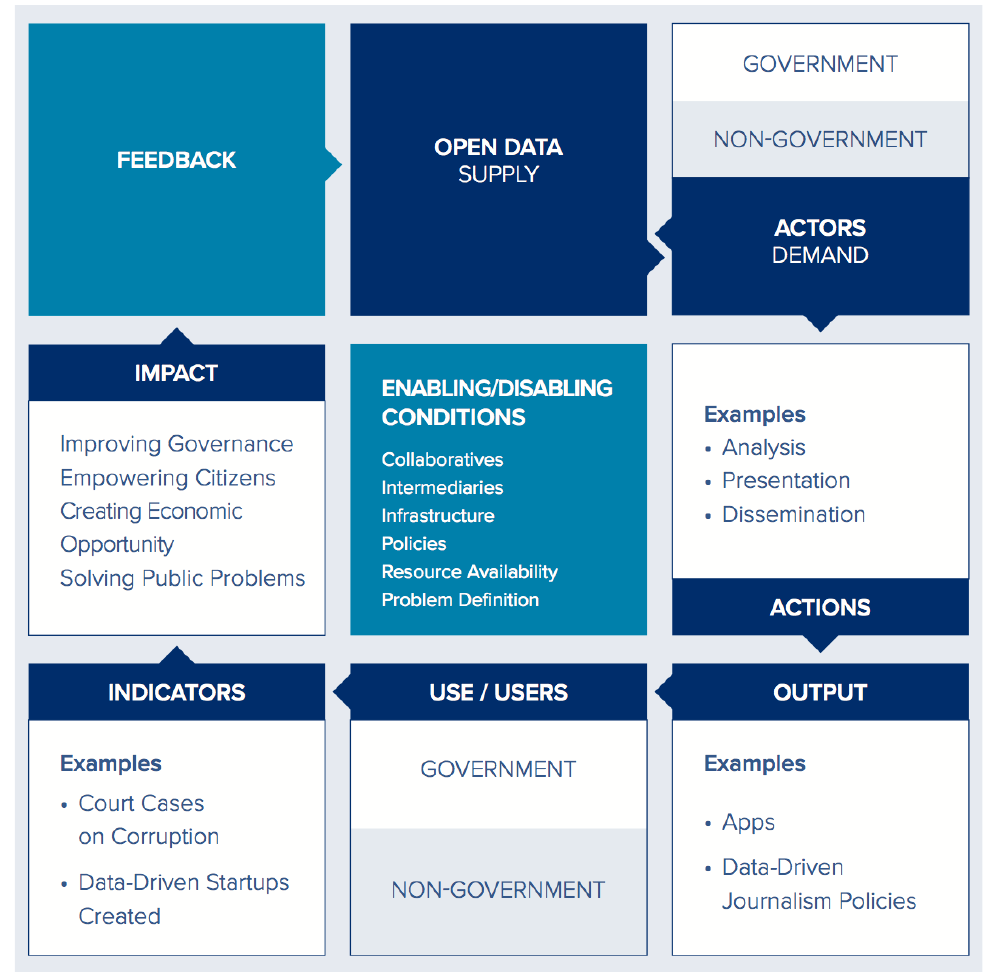
Figure 2: Open Data in Developing Economies Logic